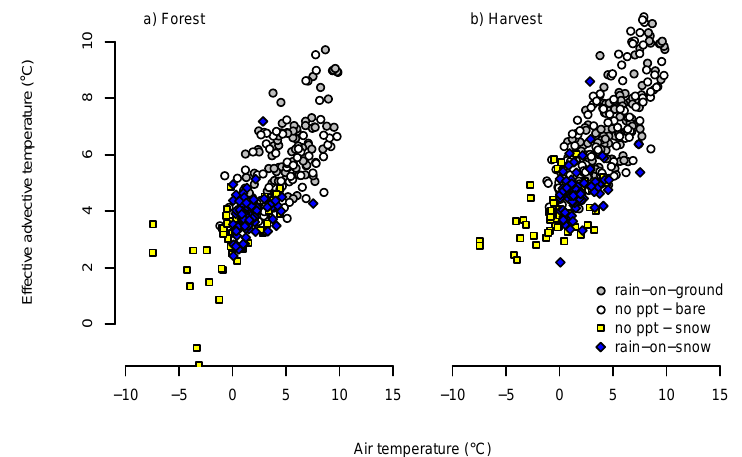
Fig. 7. Calculated mean daily effective advective temperature for four event types for the forest and harvest reaches during winter 2011/2012 and